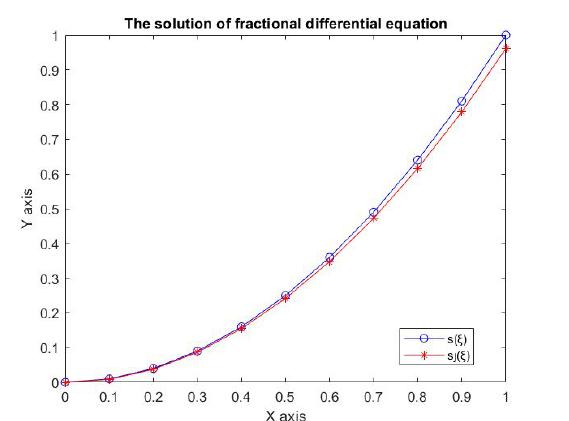
Figure 1. The convergence between an approximate and exact solution with an interval difference of 0.1 for Example 3.